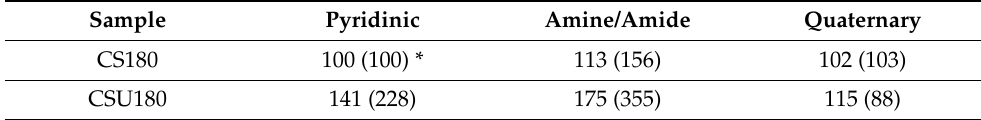
Table 2. Relative intensities of the N 1s bands (surface area of the bands). Sample